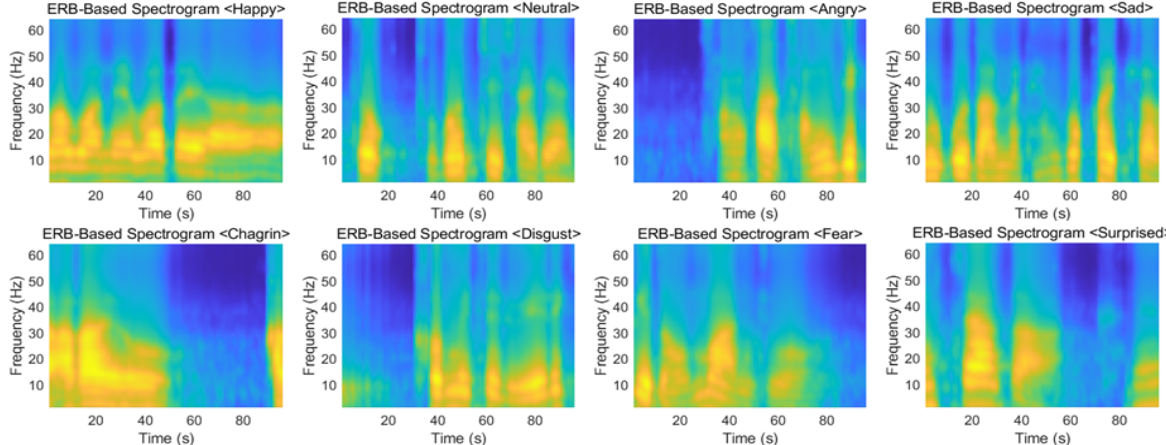
Figure 2. Visualization of ERB spectrograms for eight emotions.